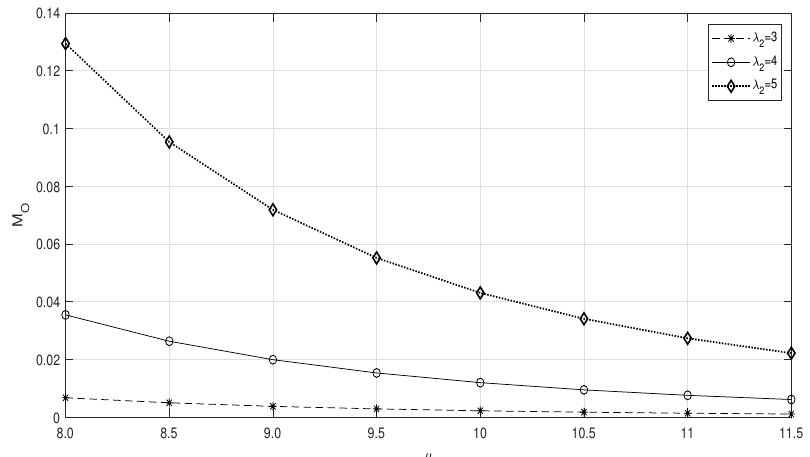
Figure 2. Mean number of customers in the orbit on λ 2 vs. µ .